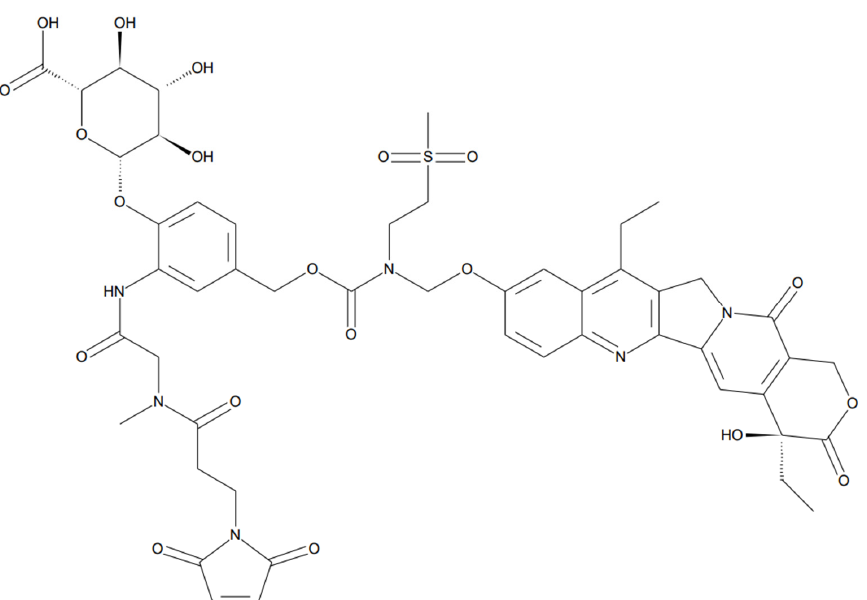
Figure 2. Structure of MAC glucuronide phenol linked SN-38 ((2S,3S,4S,5R,6S)-6-(4-(((((((S)-4,11- diethyl-4-hydroxy-3,14-dioxo-3,4,12,14-tetrahydro-1H-pyrano [3 ′ ,4 ′ :6,7]indolizino [1,2-b]quinolin- 9-yl)oxy)methyl)(2-(methylsulfonyl)ethyl)carbamoyl)oxy)methyl)-2-(2-(3-(2,5-dioxo-2,5-dihydro- 1H-pyrrol-1-yl)-N-methylpropanamido)acetamido)phenoxy)-3,4,5-trihydroxytetra-hydro-2H- pyran-2-carboxylic